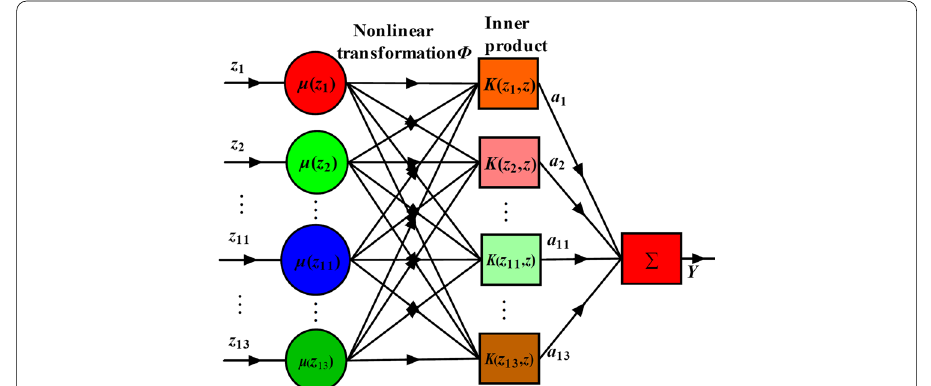
Fig. 2 Soft measurement model of the key index parameters of the new competitive advantages of China’s export based on the